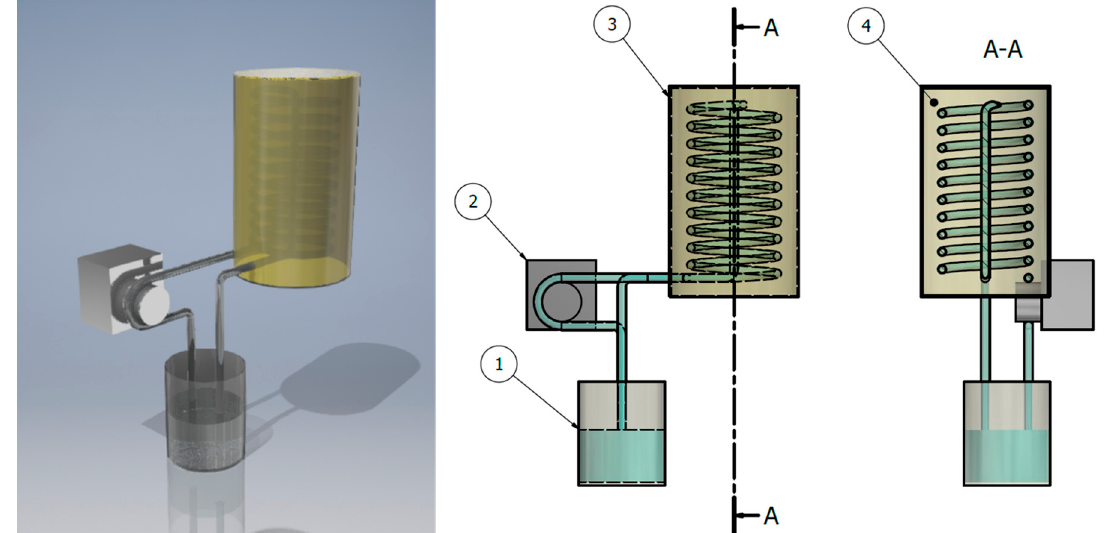
Figure 2. A 3D model of the heat management system (HMS) composed of ( 1 ) a cooling liquid reservoir, ( 2 ) a peristaltic pump, ( 3 ) a spiral radiator filled with ( 4 ) a conductive layer (the NF containing PVP ‐ PtNPs or water).